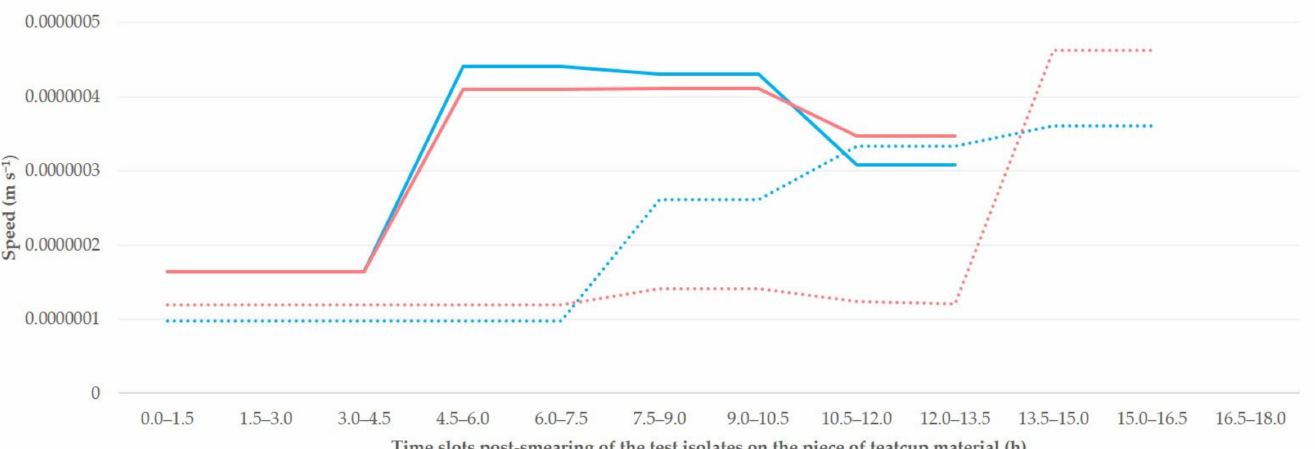
Figure 3. Median speed of linear dissemination of two isolates of S. epidermidis (isolate A: blue colour; isolate B: red colour; p > 0.25 for all comparisons) at progressive time slots after smearing of the isolates on pieces of teatcup material from milking parlours for cattle (dotted line) or sheep (solid line) ( p < 0.003 for all comparisons).